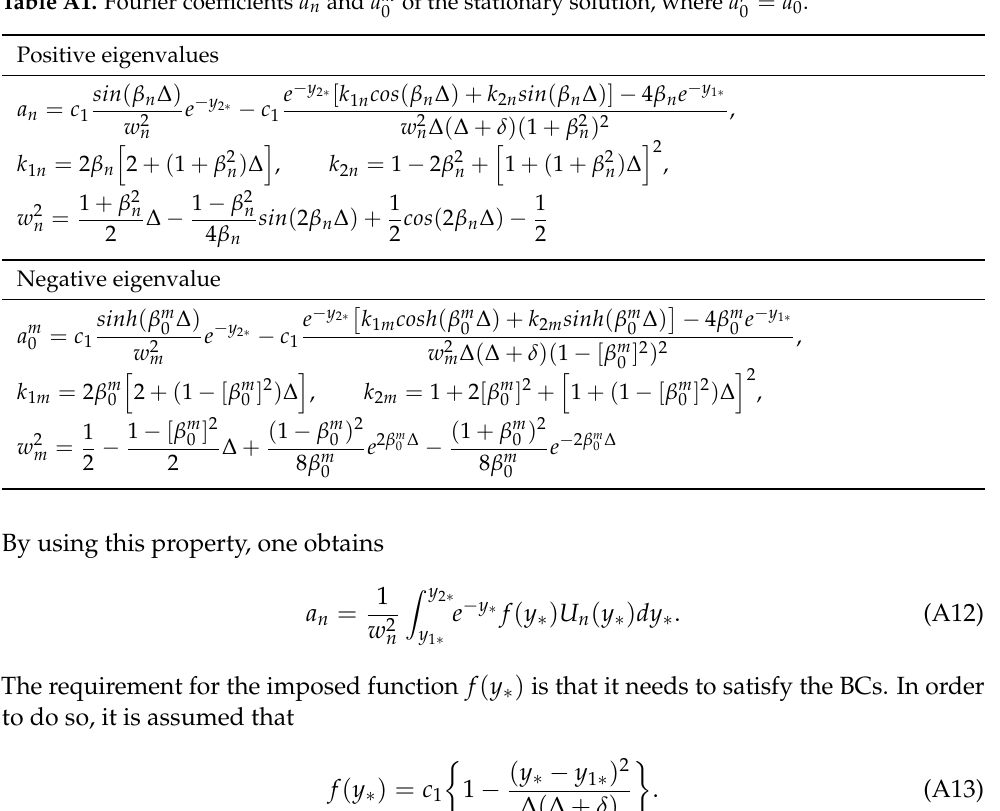
of the stationary solution, where a p 0